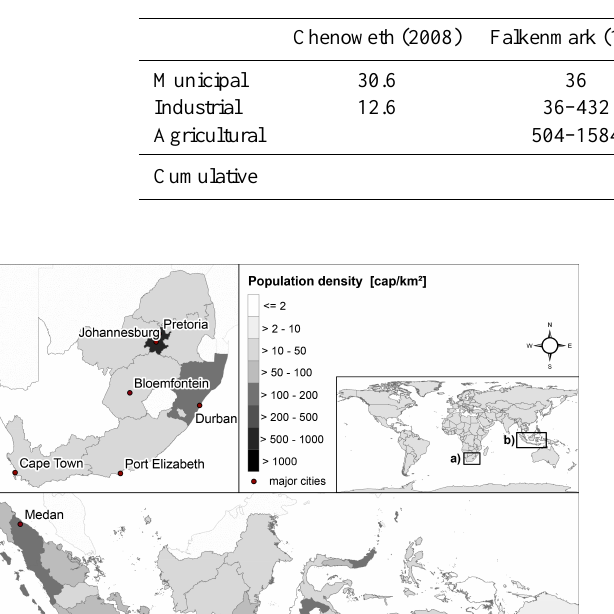
Figure 1. Conceptual overview of the determinants of sectoral water adequacy and the aggregation process. Table 1. Overview of sectoral water needs according to different sources, all converted to m 3 cap − 1 yr − 1 .